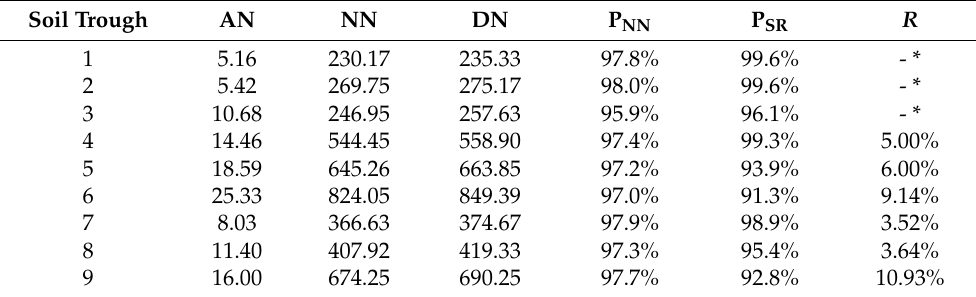
Table 4. Ammonia nitrogen (AN), nitrate nitrogen (NN) and dissolved nitrogen (DN) losses (mg) from soil troughs, and the proportion of nitrate nitrogen in dissolved nitrogen loss (P NN ), the proportion of dissolved nitrogen loss through surface runoff (P SR ) and dissolved nitrogen runoff loss coefficient ( R ).